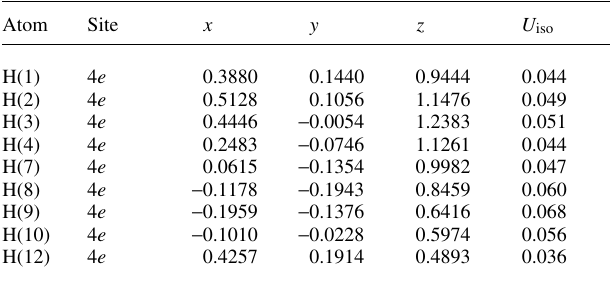
Table 2. Atomic coordinates and displacement parameters (in Å 2 ) . Table 2. Continued